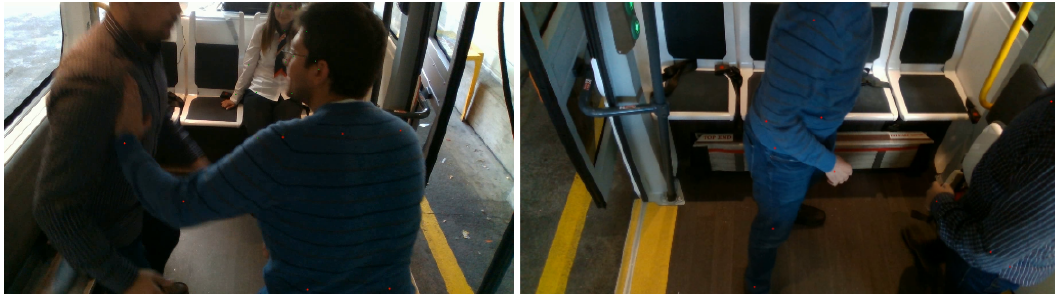
Figure 5. Examples indicating the restricted field of view of the camera